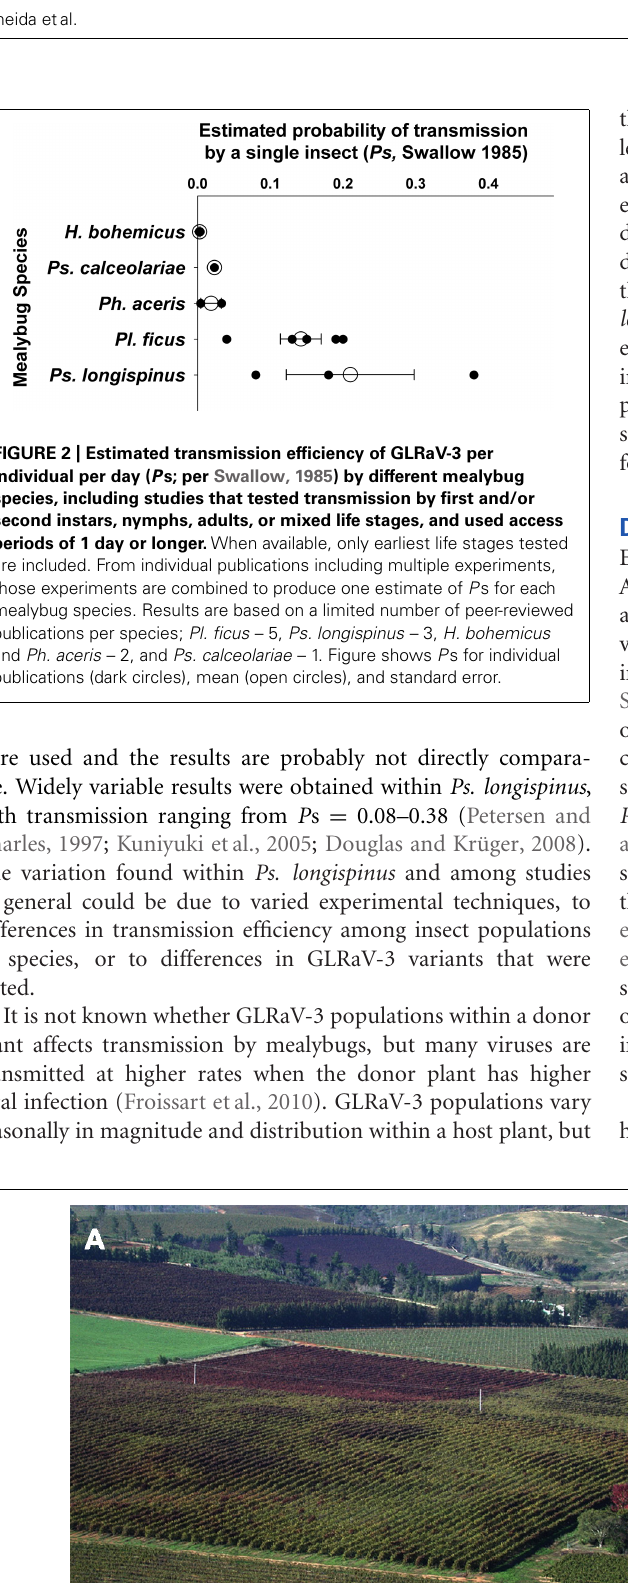
FIGURE 3 | (A) Vineyards with high GLD incidence (dark red) serve as source of inoculum for adjacent blocks, in which disease spatial distribution is patchy, suggesting initial introduction of virus into uninfected blocks followed by